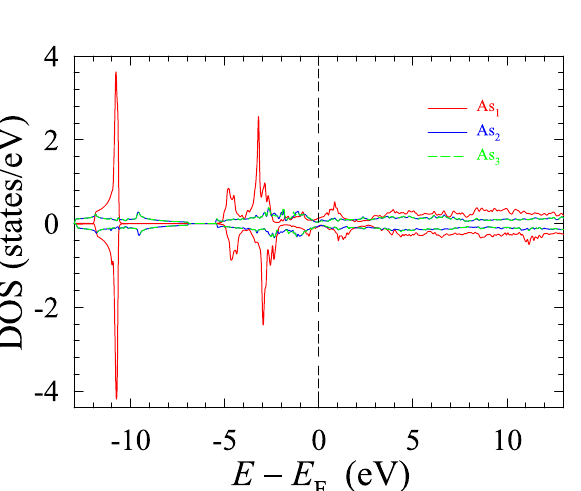
Figure 5. Spin-resolved DOS of As. SigmaPlot v14, www. systa tsoft ware.